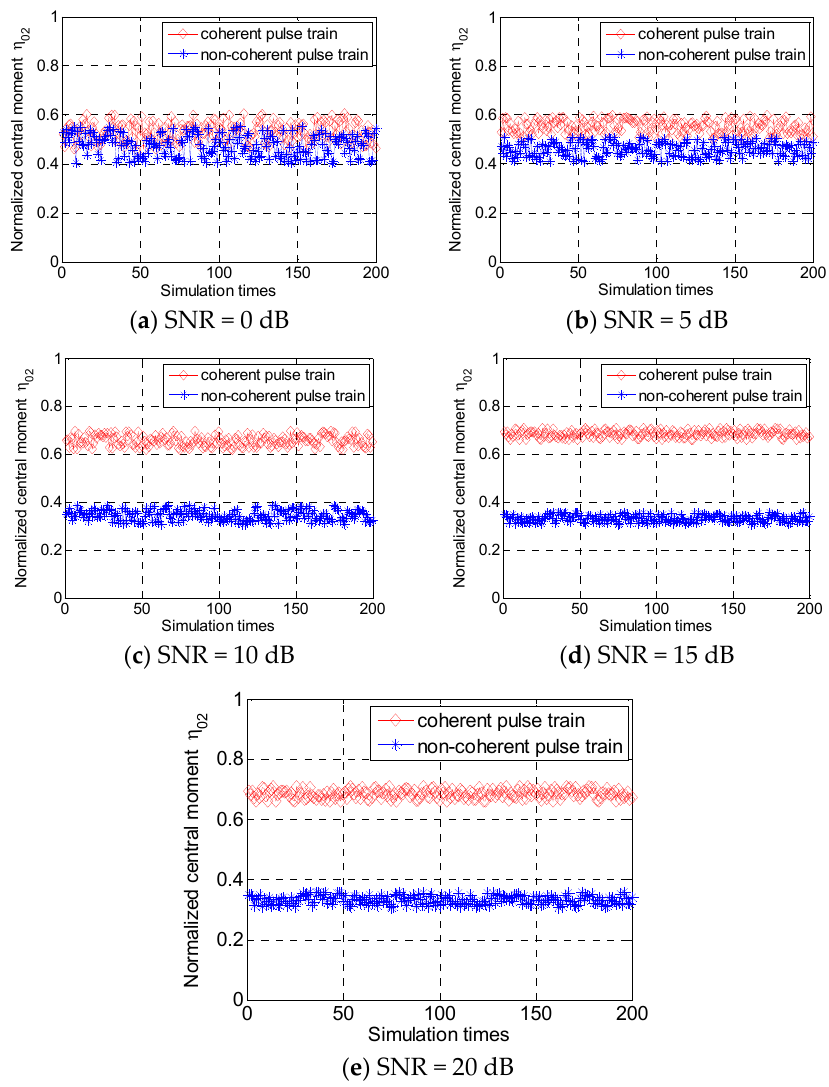
Figure 5. Normalized central moment (NCM) of spectrum image in different signal-to-noise ratios (SNRs).